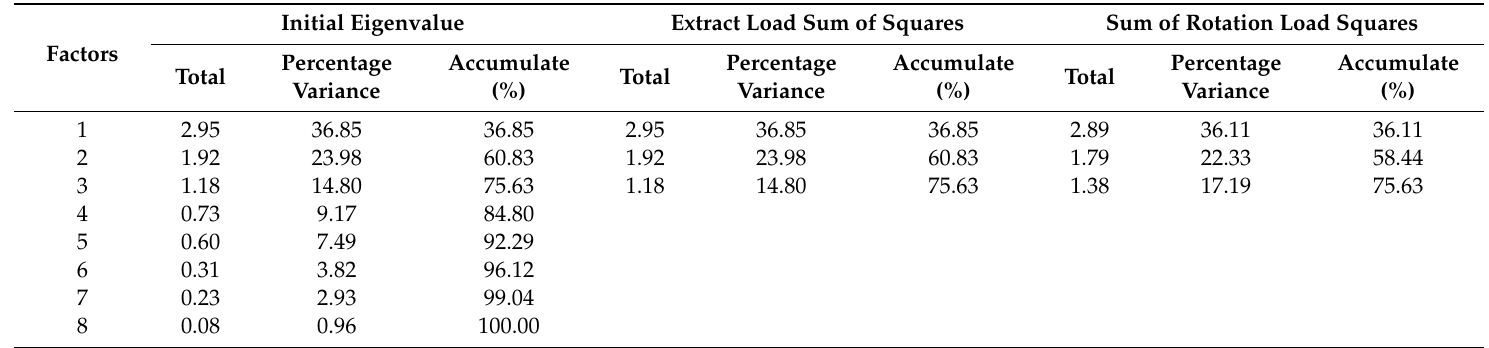
Table 4. Factor total variance